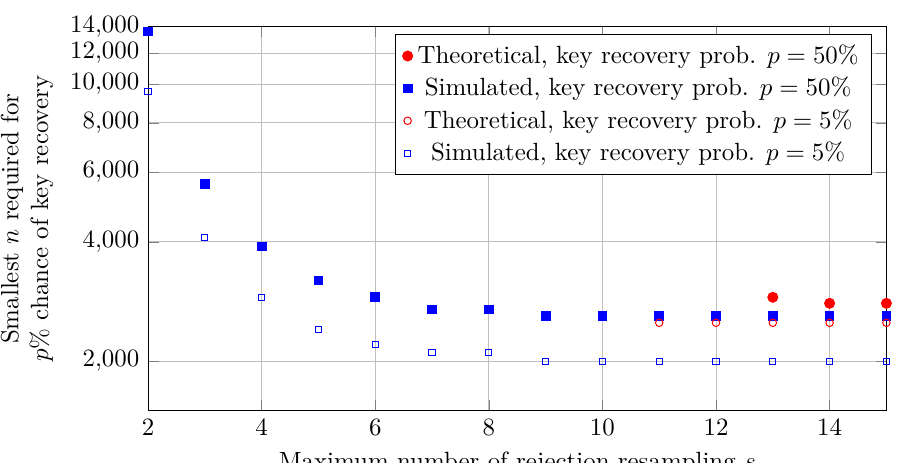
Figure 14: Key recovery parameter tradeoff, showing the smallest number of ciphertexts n (rounded up to the nearest 100) that result in 50% and 5% probability of key recovery, for κ of length 400, and the value of s on the